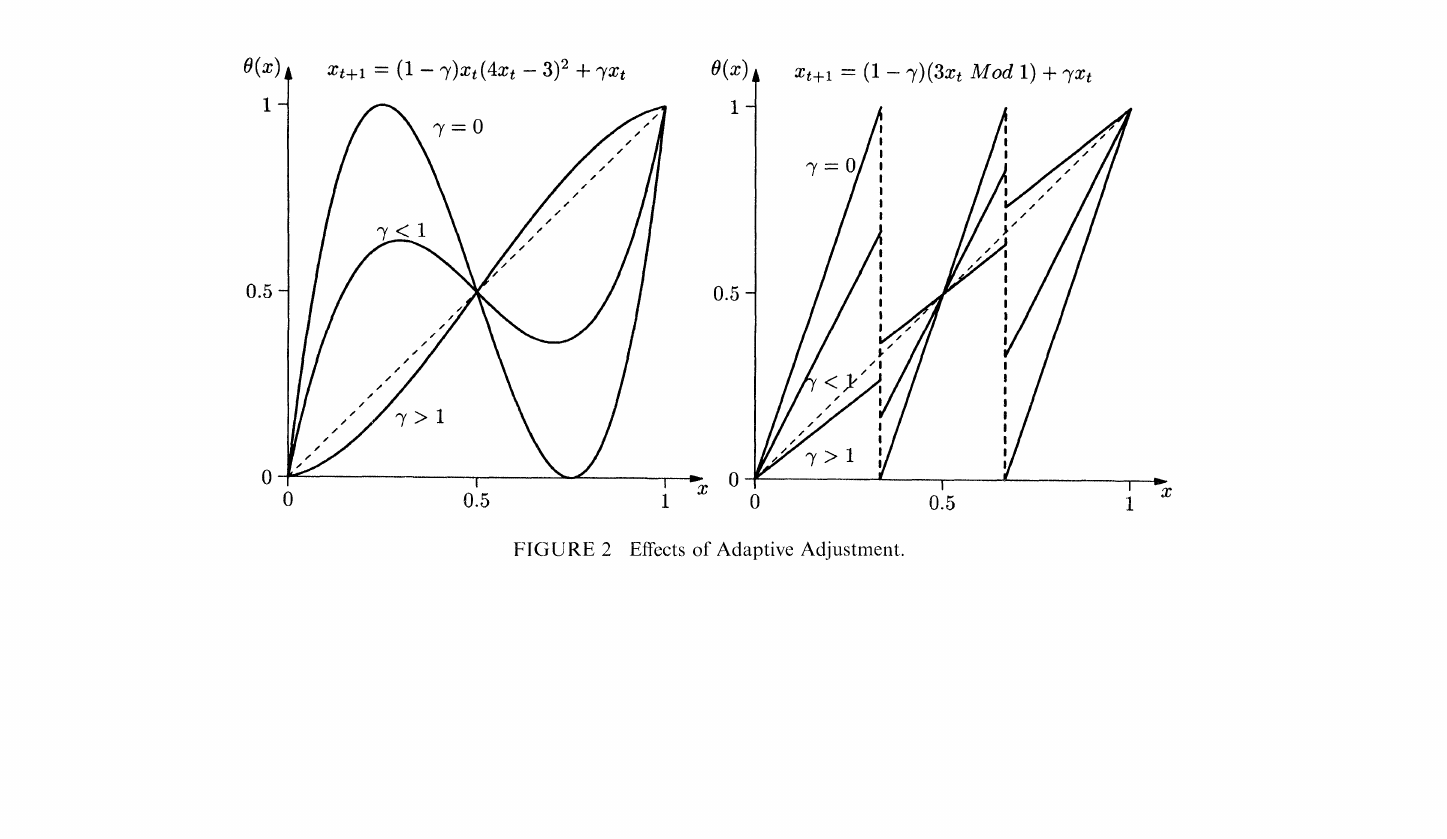
FIGURE 2 Effects of Adaptive